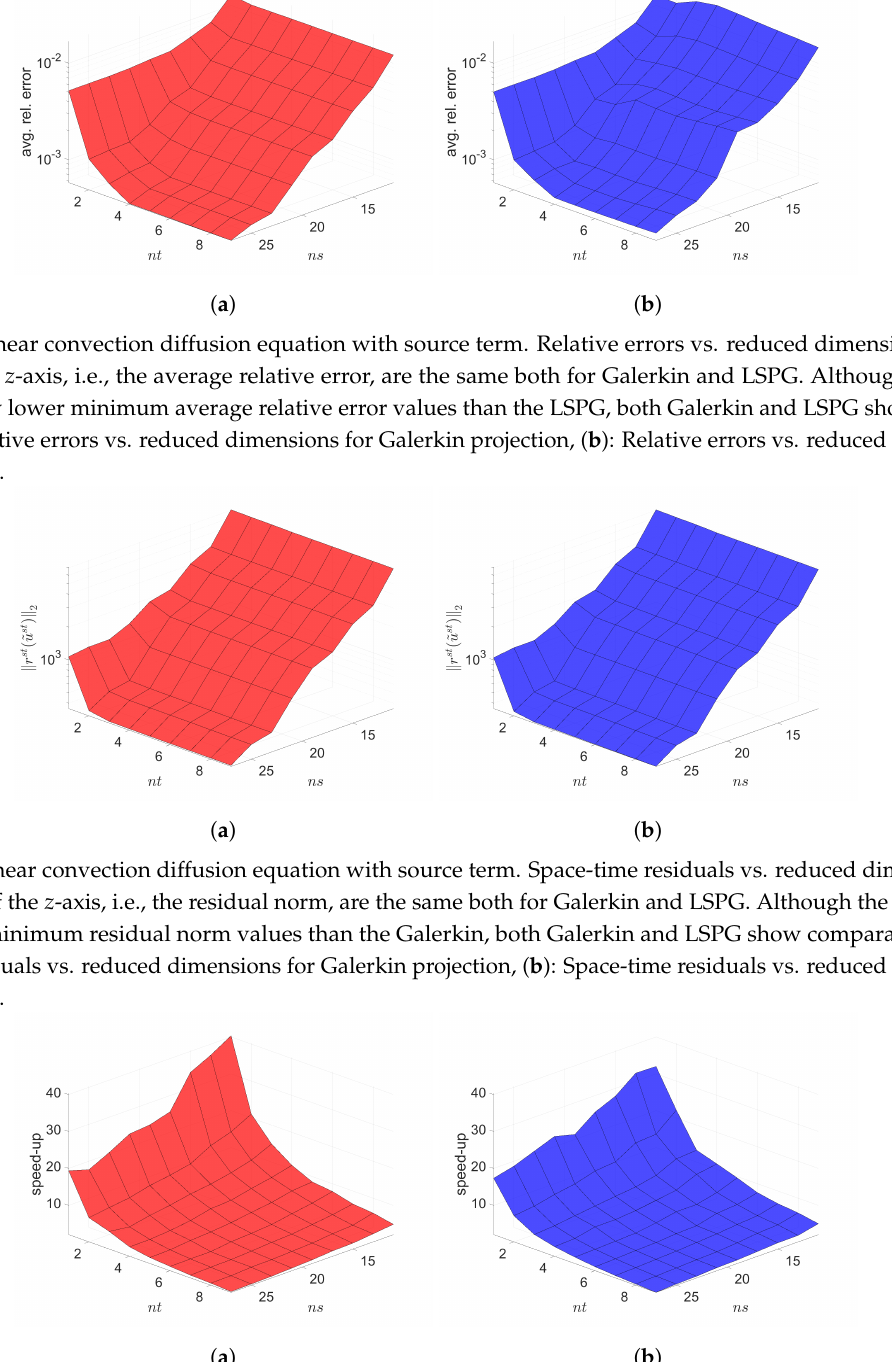
Figure 20. 2D linear convection diffusion equation with source term. Online speed-ups vs. reduced dimensions. Both Galerkin and LSPG show similar speed-ups. ( a ): Online speed-ups vs. reduced dimensions for Galerkin projection, ( b ): Online speed-ups vs. reduced dimensions for LSPG